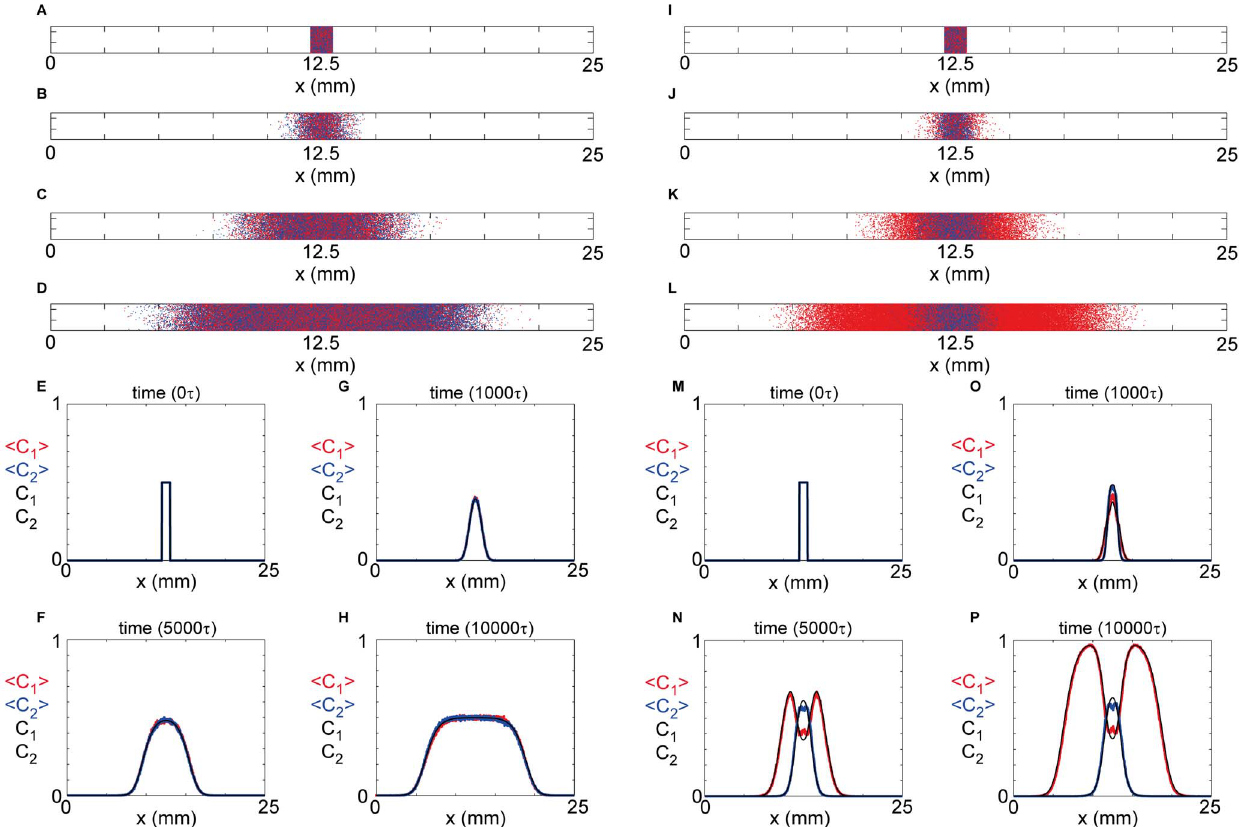
Figure 2. Two-dimensional modeling results for a scratch assay. Discrete snapshots of a two dimensional scratch assay in a narrow channel geometry with 0 ƒ x ƒ 25 mm and 0 ƒ y ƒ 1 : 25 mm (A–D, I–L). The initial condition for two different simulations corresponds to a confluent monolayer of agents in the central region of the domain, where 12 ƒ x ƒ 13 mm. The initial population is made up of 50% subpopulation 1 (red disks) and 50% subpopulation 2 (blue disks). The first simulation corresponds to identical subpopulations with P 1 the second simulation corresponds to distinct subpopulations with P 1 (B,J), 5000 (C,K) and 10000 (D,L) time steps, where each time step has a duration of t . Both types of discrete simulation were repeated using M ~ 100 identically prepared realizations to to produce the averaged density profiles for the case where both subpopulation are identical (E–H) and where the subpopulations are distinct (M–P). The numerical solution of Equation (5) was obtained for the initial condition given by Equations (8)–(9) and superimposed on the averaged discrete results (E–H, M–P). The numerical solutions were obtained using d x ~ 2 : 5 | 10 { 3 mm and d t ~ 0 : 1 t